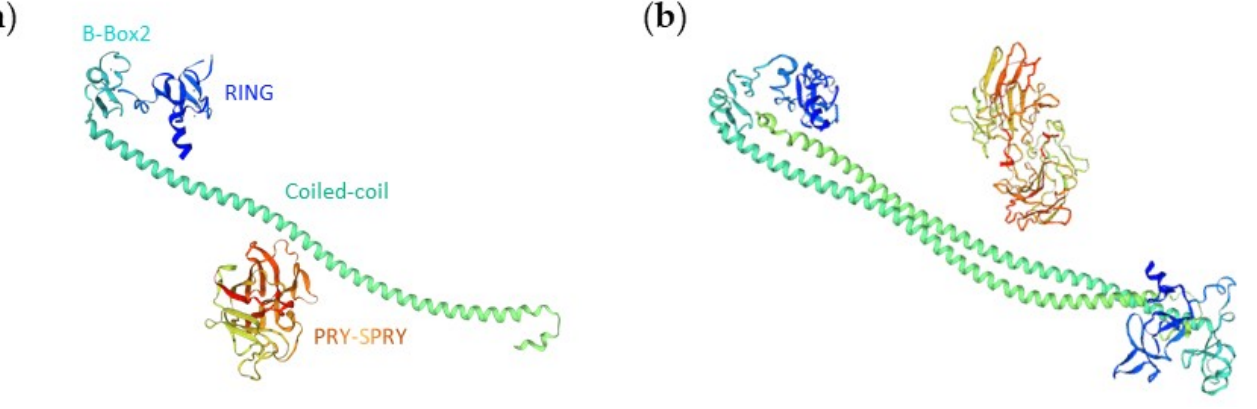
Figure 6. ( a ) Predicted monomeric 3D structure of tripartite motif and PRY-SPRY domains of human TRIM17 (Q9Y577) based on TRIM28 (6QAJ.1A) and PYRIN (2WL1.1A), respectively (from Swiss Model Repository database); ( b ) predicted 3D structure of TRIM17 homodimers based on homodimers of tripartite and PRY-SPRY domains of TRIM28 and PYRIN respectively (from Swiss Model Repository database).